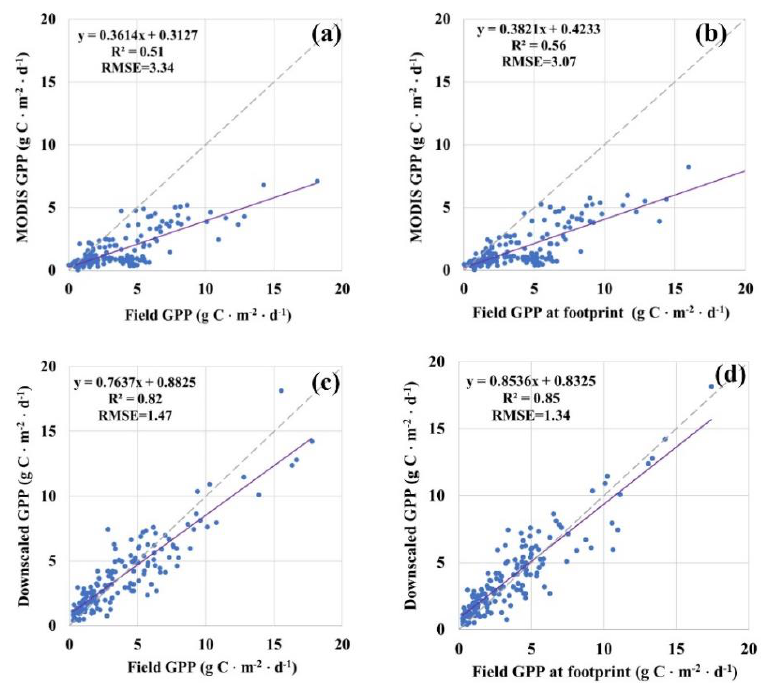
Figure 6. Validation of MODIS GPP and downscaled GPP. ( a ) Validation of MODIS GPP at field scale; ( b ) validation of MODIS GPP at footprint scale; ( c ) validation of downscaled GPP at field scale; ( d ) validation of downscaled GPP at footprint scale.